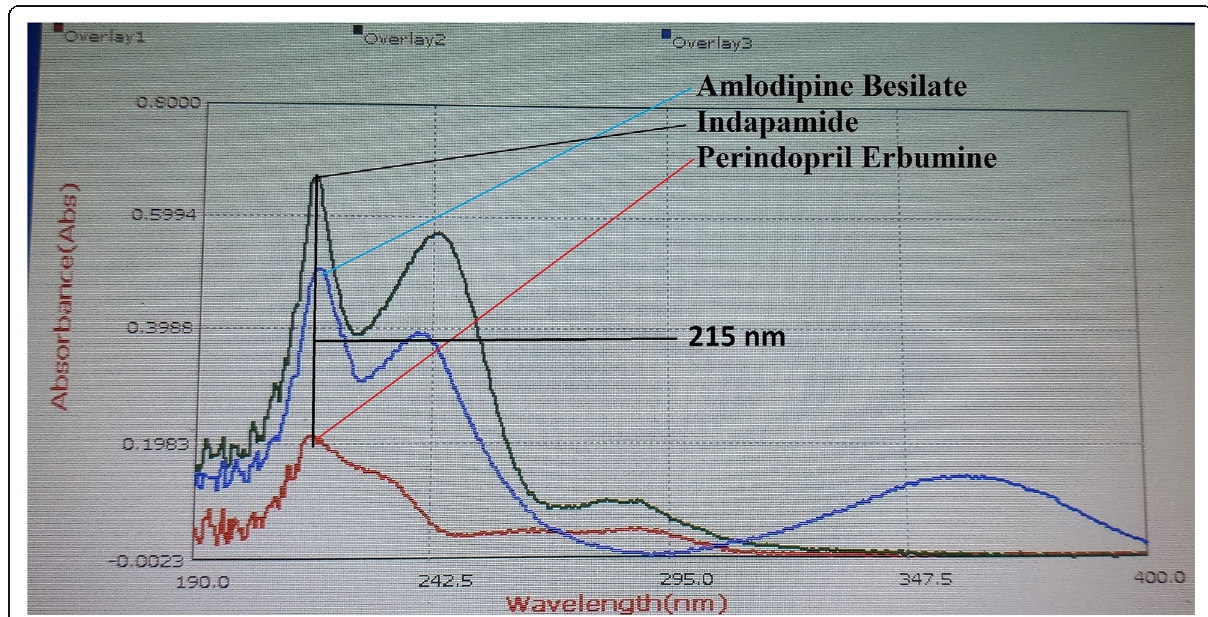
Fig. 2 UV visible overlay spectra of Perindopril erbumine, Indapamide, and Amlodipine besylate for selection of analytical wavelength (10 μ g/ml)